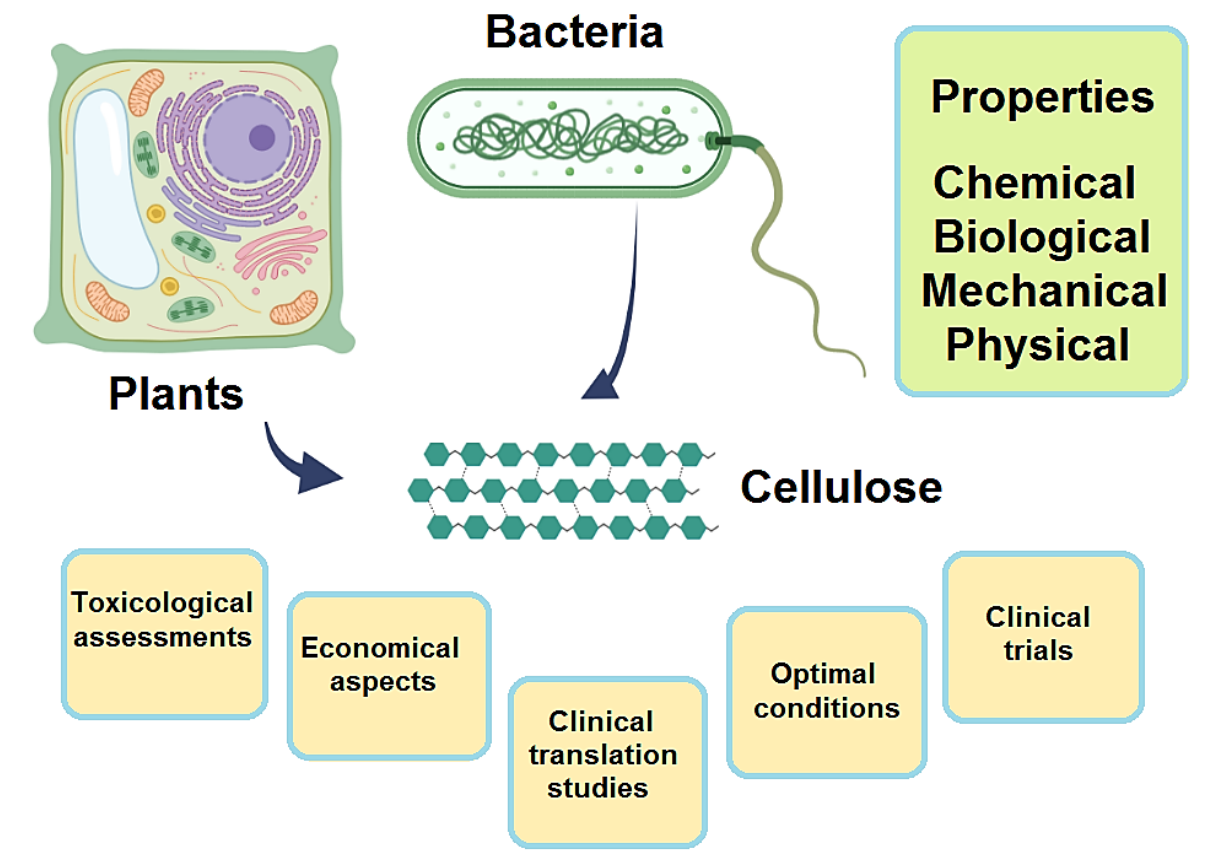
Figure 1. Crucial aspects and properties of cellulose-based tissue engineering scaffolds . Table 1. Some selected examples of cellulose- based scaffolds with tissue engineering applications .